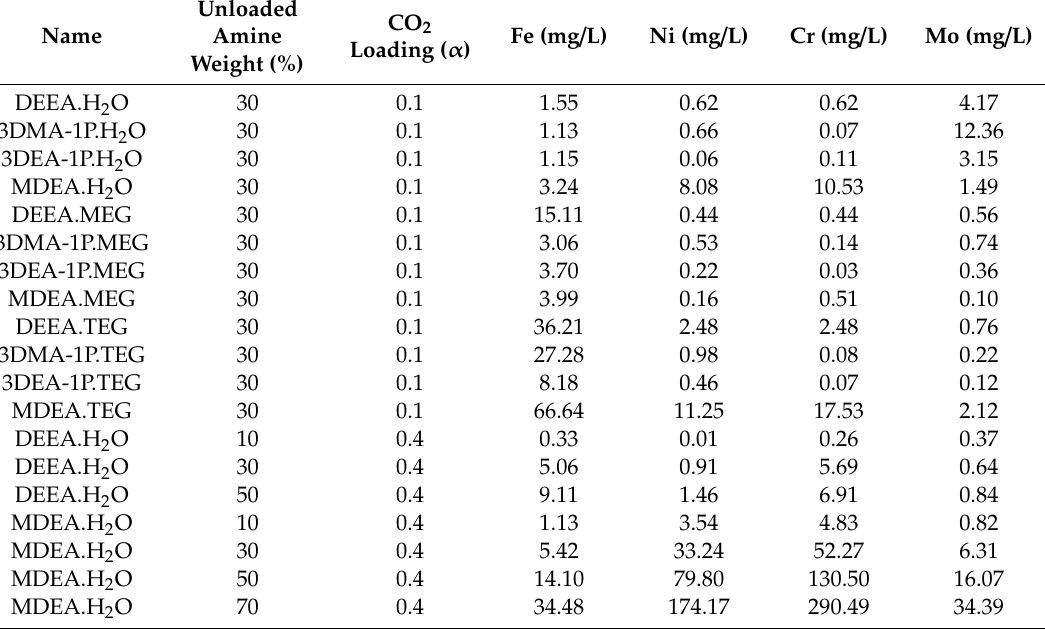
Table A2. Various metal concentrations (mg / L) in all solutions after five